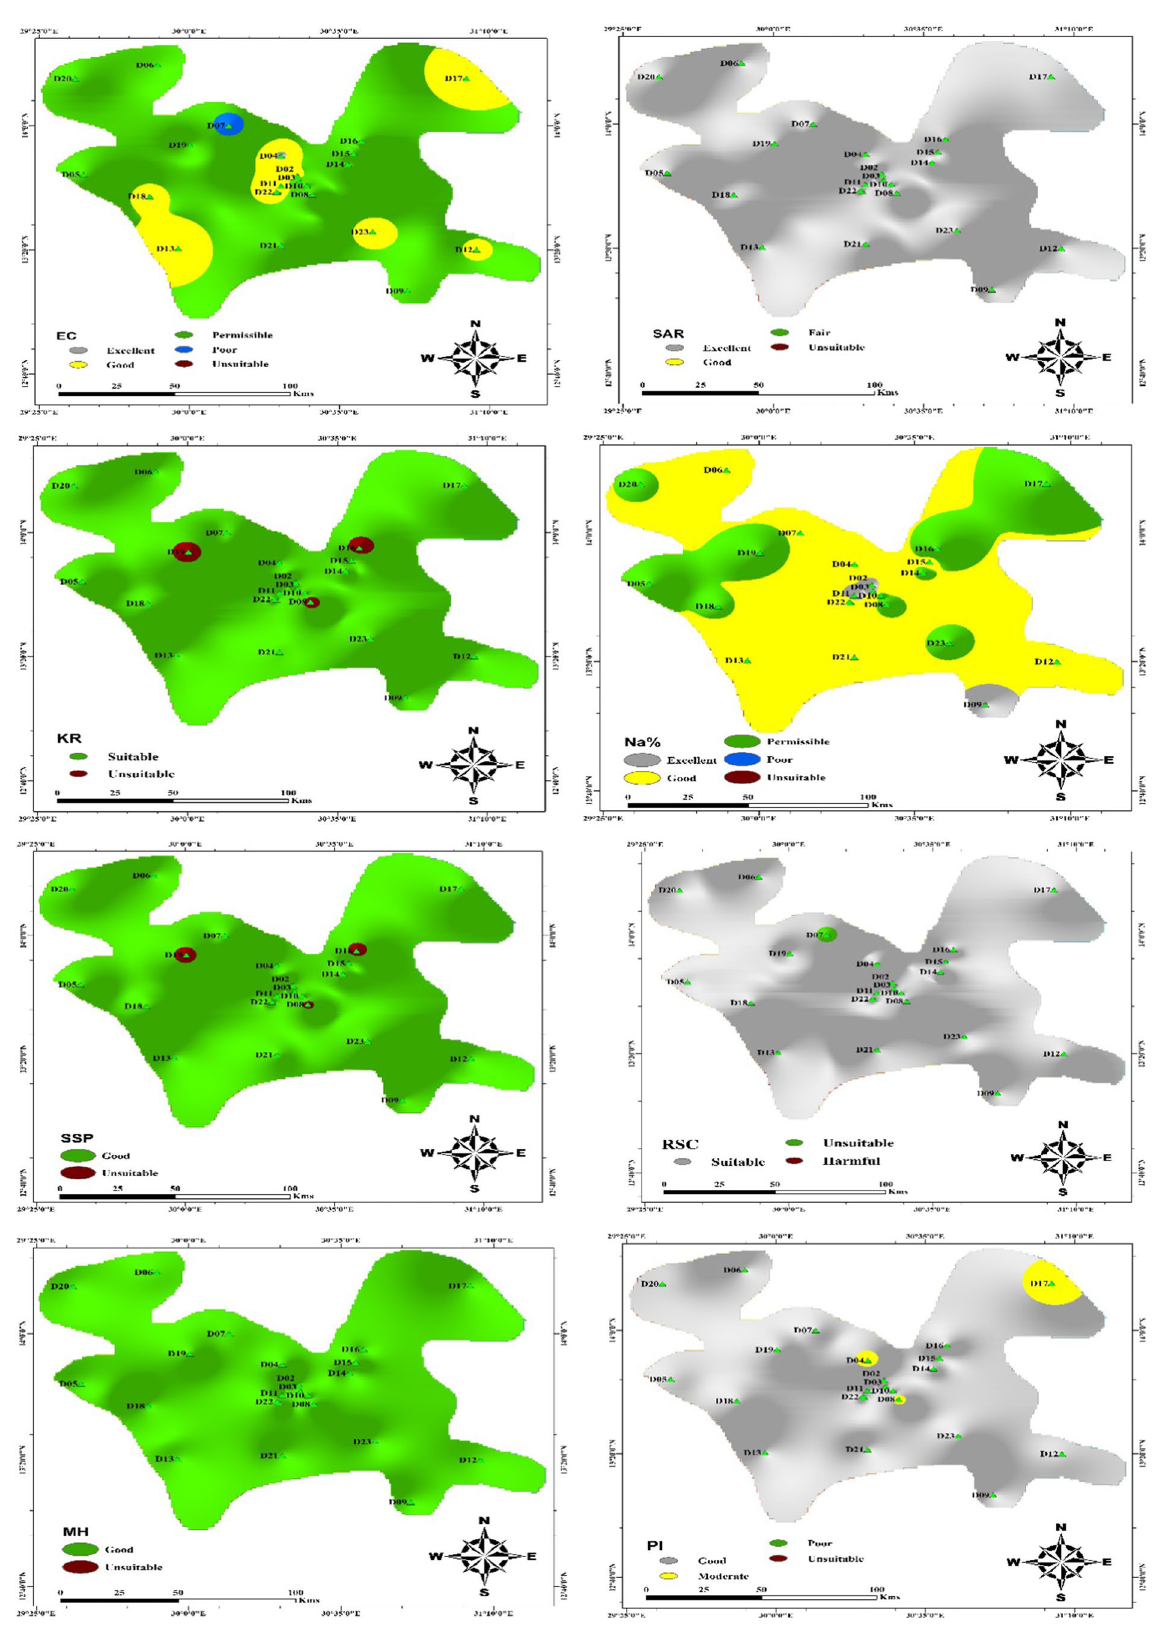
Fig. 8 Spatial distribution of GIS interpolation maps of the irrigation quality indices results (EC, SAR, KR, Na%, SSP, RSC, MH, and PI) in unconfined